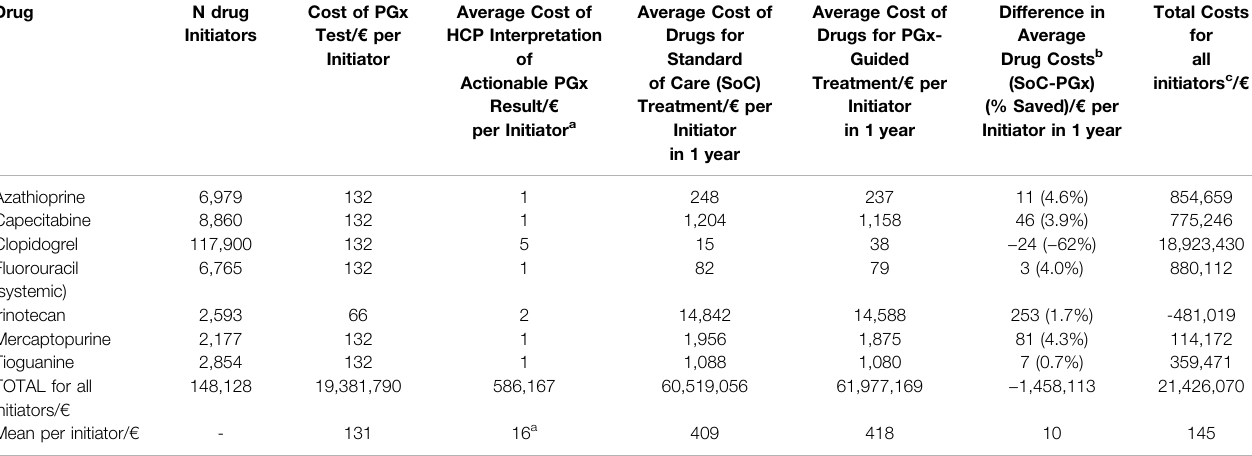
TABLE 2 | Overall Costs of PGx-testing, pharmacist and physician time for interpretation and drug treatment. Drug N drug Cost of PGx Initiators Test/ €